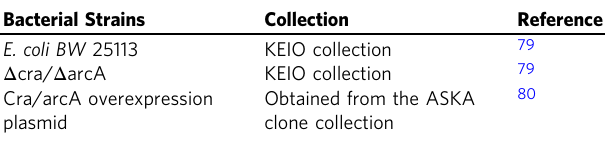
Table 1 List of E. coli